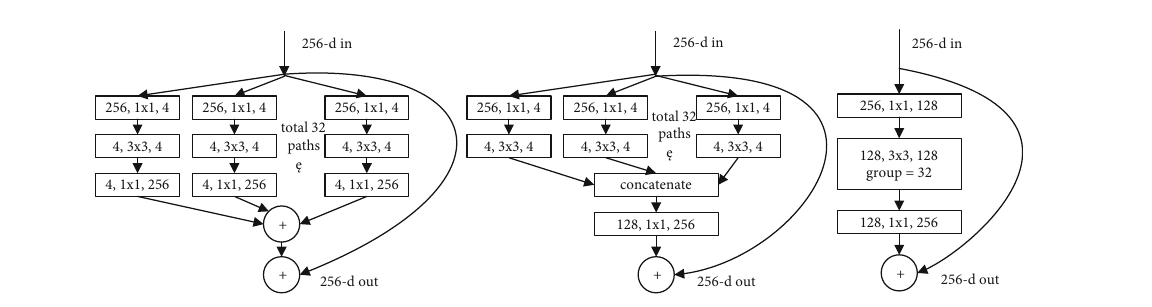
Figure 9: Basic units of